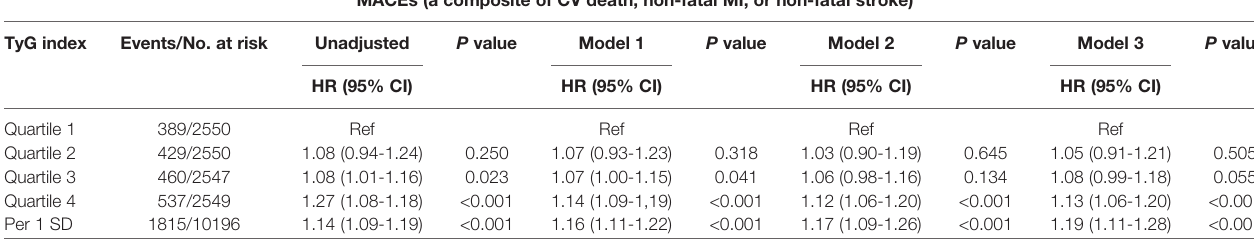
TABLE 2 | Risk of incident MACEs and major coronary events for baseline TyG index. MACEs (a composite of CV death, non-fatal MI, or non-fatal stroke)